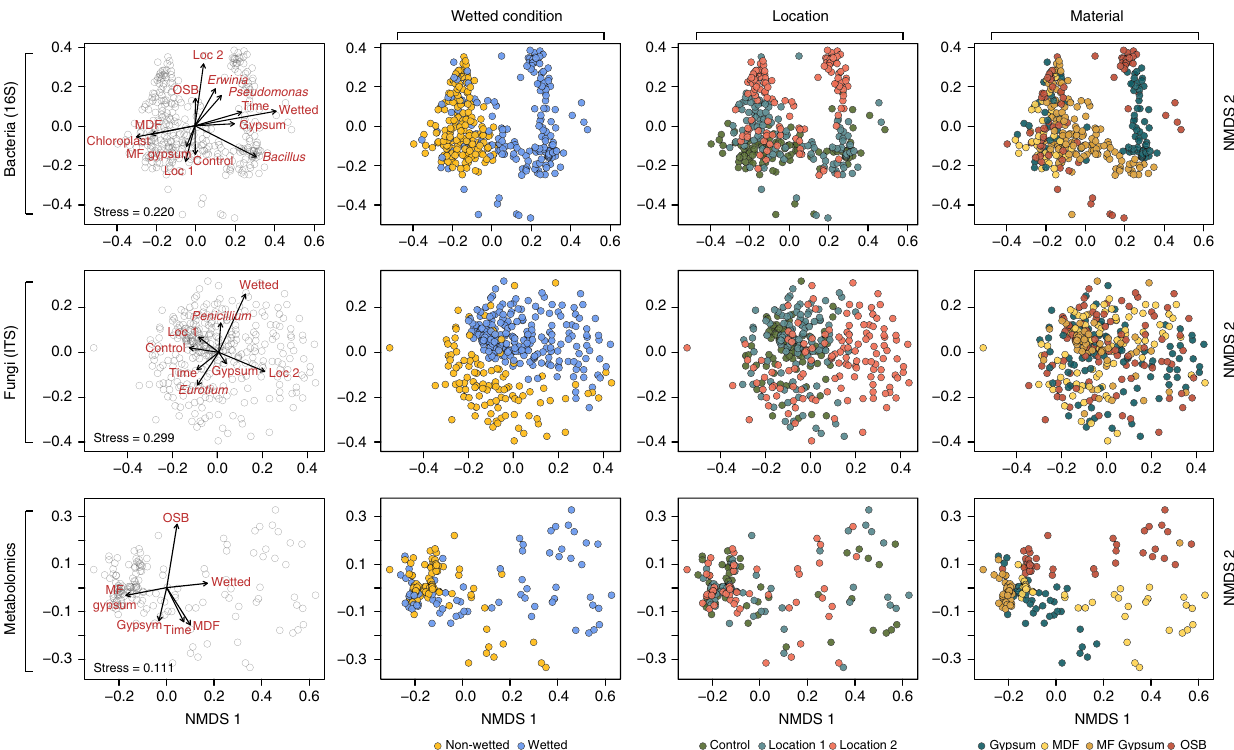
Fig. 4 NMDS plots illustrate clustering of sample diversity by sample type. Each row comprises four identical NMDS plots ( n = 338, 330, and 144 samples for 16S, ITS, and Metabolomics, respectively). The leftmost plot illustrates the ordination ’ s association with environmental variables and the remaining plots color sample points by various metadata factors. The stress on the NMDS plot is indicated in the rightmost plot in each row error. NMDS non-metric multi-dimensional